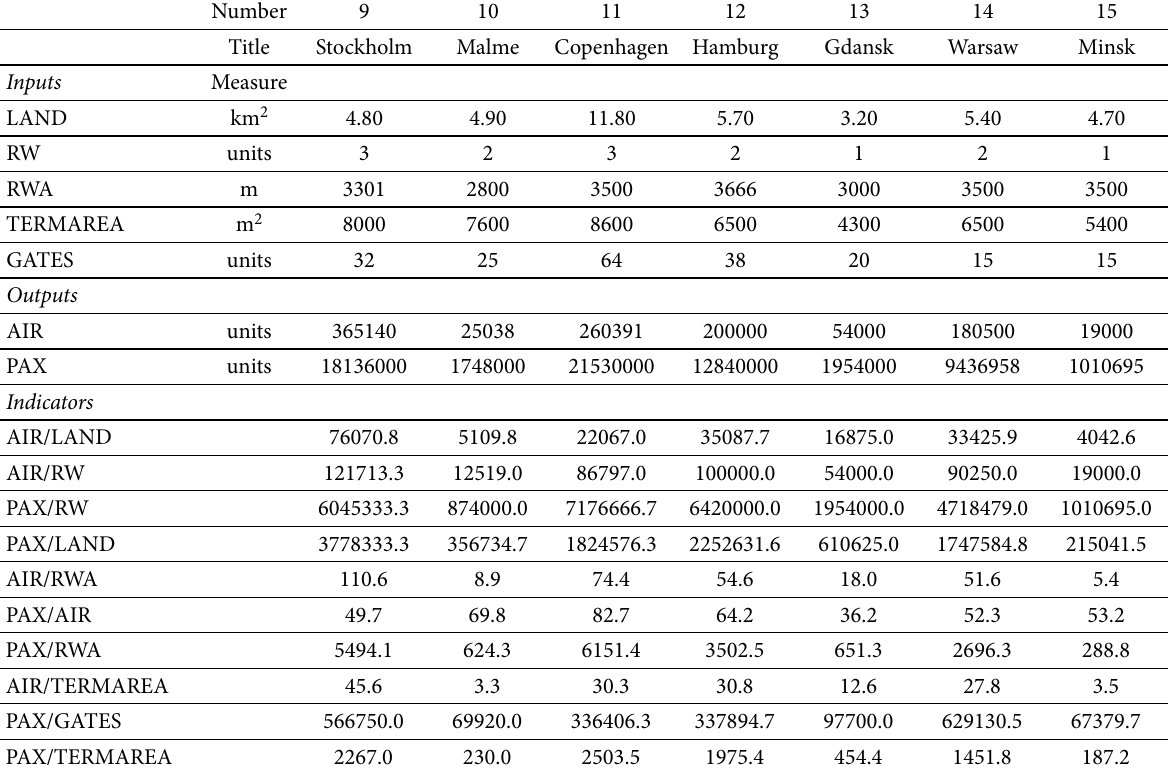
Table 2. The parameters of the airports selected for study